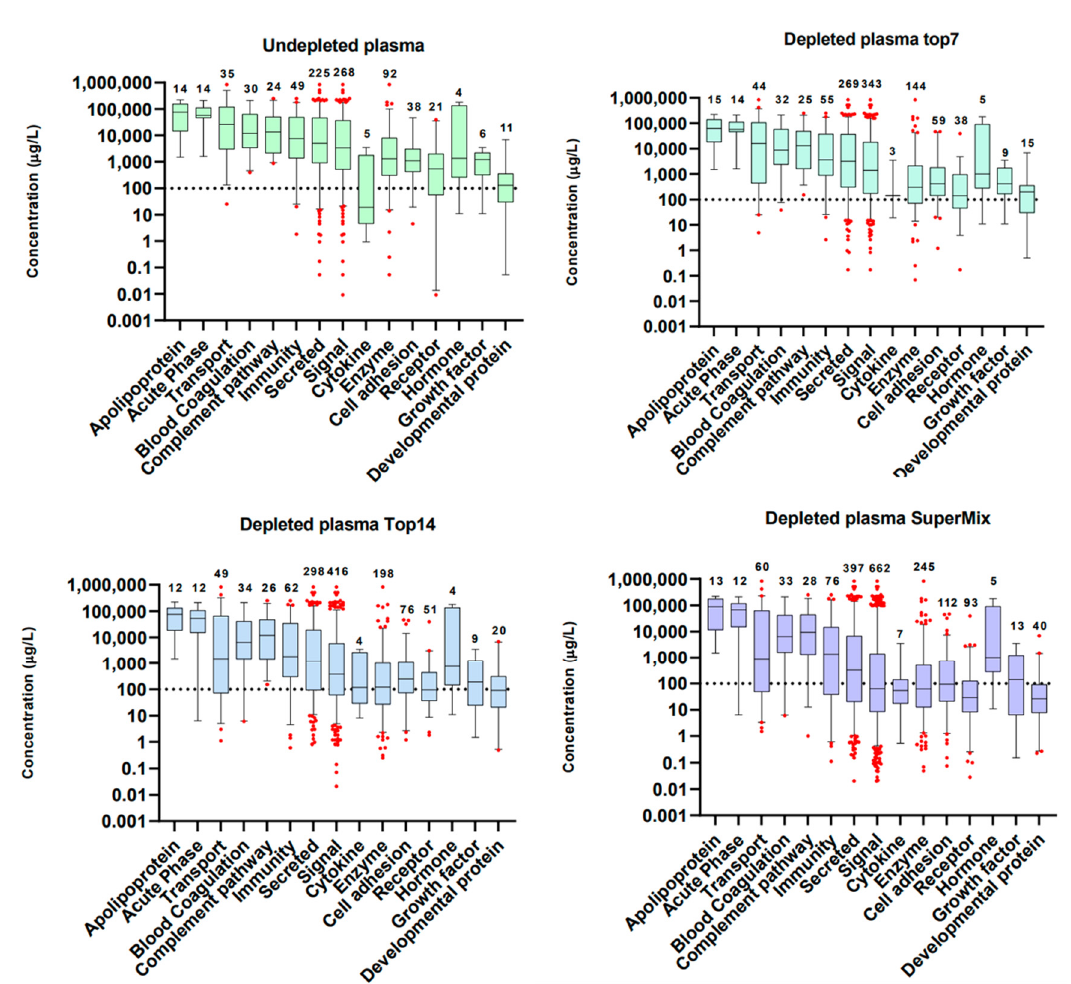
Figure 3. Functional groups identified in whole and immunodepleted plasma samples. The proteins were annotated using the information included in The Human Protein Atlas database for plasma proteins (https://www.proteinatlas.org/search/protein_class:Plasma+proteins, accessed on: 29 July 2020) [45–47]. The graphs were built using the protein concentrations in blood reported in the same database. The boxes represent the median and whisker ranges: 5th–95th percentiles.